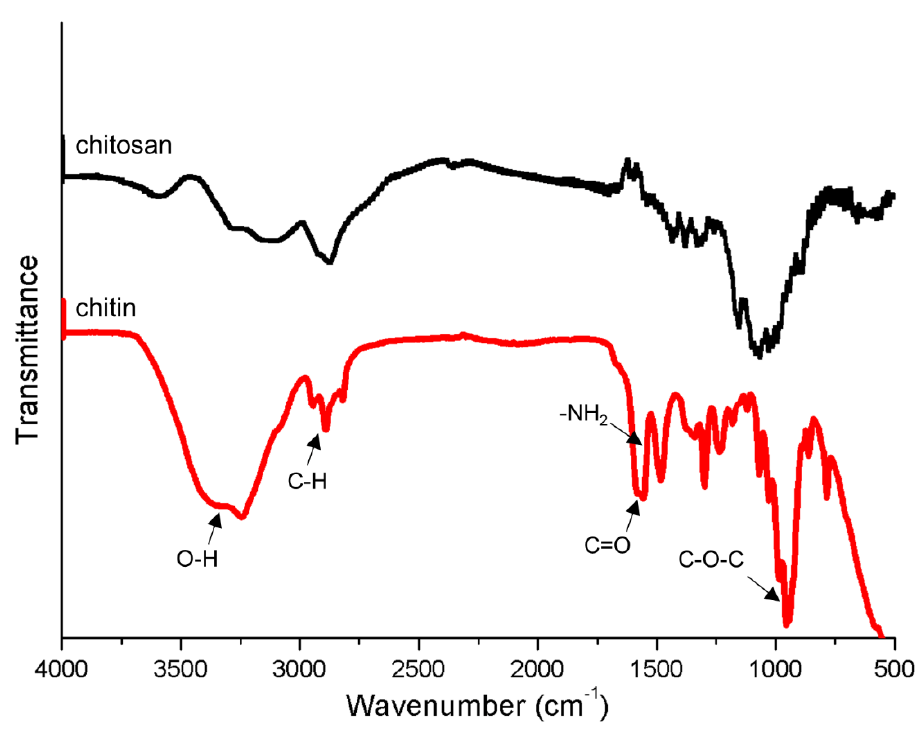
Figure 7. FTIR spectra of chitin and chitosan films.